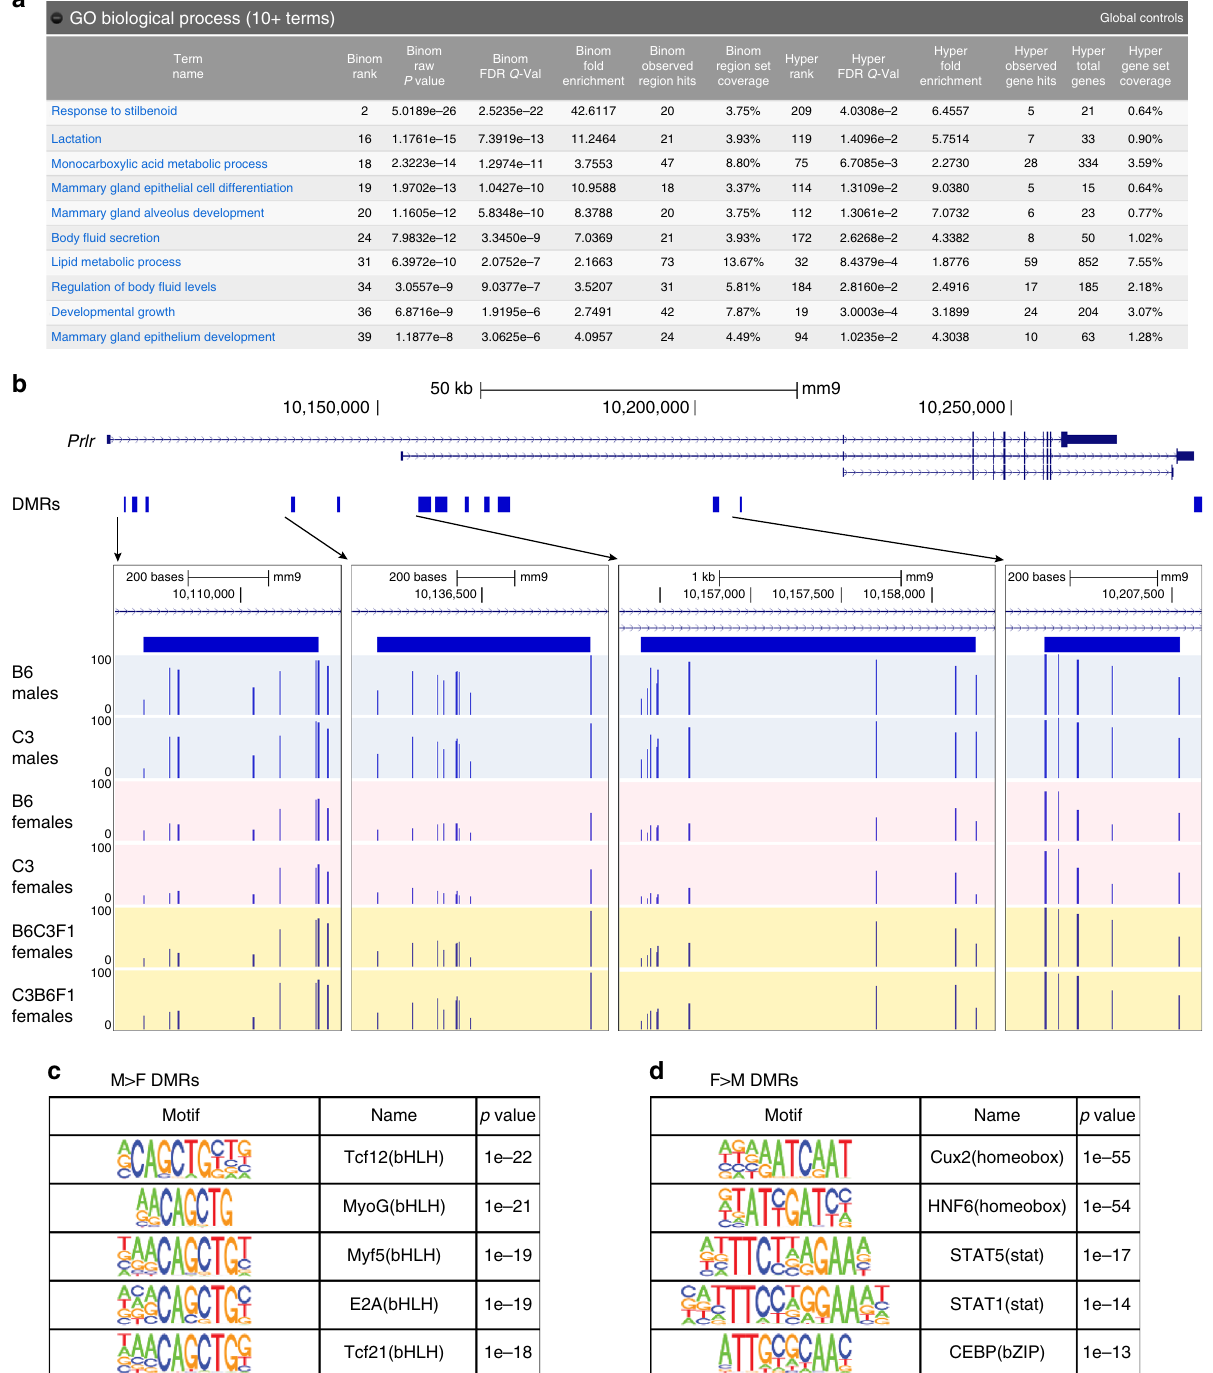
Fig. 7 DMRs hypomethylated in females suggest link to pregnancy and lactation. a Top ten biological processed reported by GREAT v3.0.0 for DSS male > female DMRs. Bold text indicates signi fi cance scores. b Genome browser view of prolactin receptor gene locus, with zoomed panels showing CpG methylation level in parental males, parental females, and F1 females at exemplar male > female DMRs. c Top fi ve enriched TF motifs in male > female DSS DMRs (after expanding DMR size to a minimum of 401 bp) according to HOMER v4.9.1. d Top fi ve enriched TF motifs in female > male Metilene DSS (after expanding DMR size to a minimum of 401 bp) according to HOMER v4.9.1